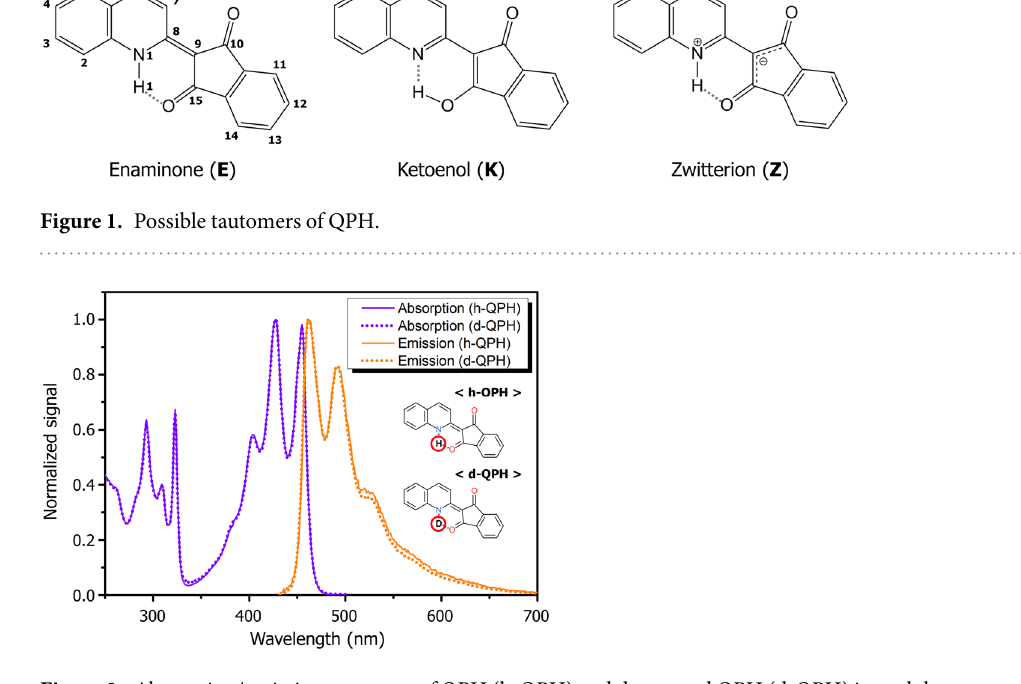
Figure 2. Absorption/emission spectrum of QPH (h-QPH) and deuterated QPH (d-QPH) in